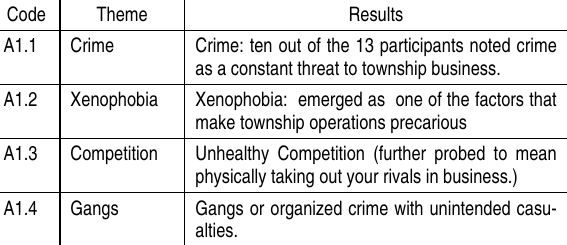
Table 2. Typical correlates of